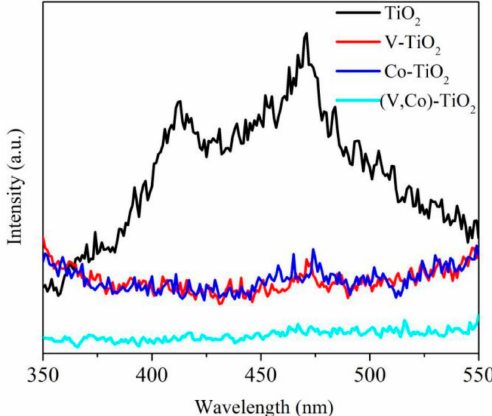
Figure 8. PL spectra of TiO 2 , V–TiO 2 , Co–TiO 2 , and (V,Co)–TiO 2